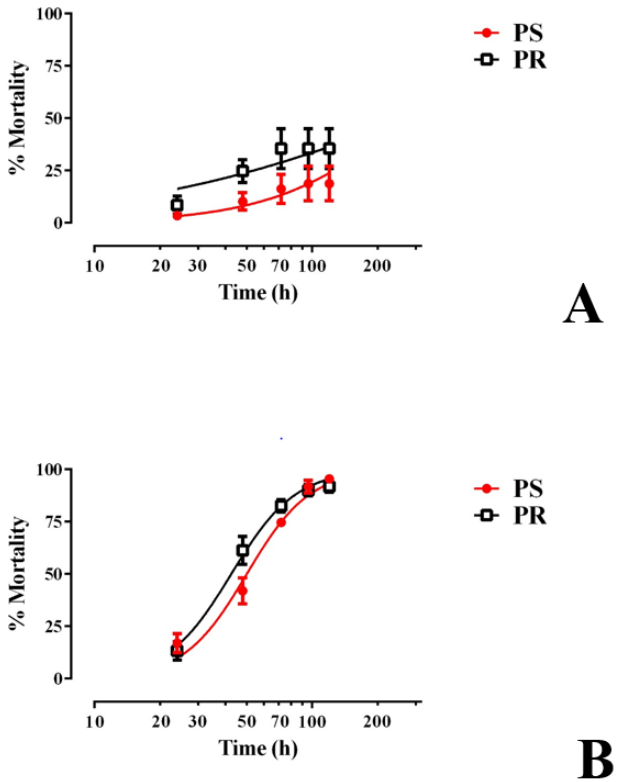
Figure 3. Chronic larval toxicity of E1800 against representative pyrethroid-susceptible (PS, red) and pyrethroid-resistant (PR, black) strains of Ae. aegypti . E1800 was tested at concentrations of ( A ) 0.1 mg/mL or ( B ) 0.25 mg/mL. The ‘x axis’ in both panels is log transformed and represents the time in which larvae were exposed to E1800 up to 120 h; points after this time remained consistent until the experiment was finalized (14 days = 264 h). Values plotted are means ± standards errors of the mean based on four replicates of 30 larvae for PS or six replicates of 30 larvae for PR. At 0.25 mg/mL E1800, the median lethal time (LT 50 ) of the PR strain (42.5 h, 38.7–46.6 h 95% CI) was significantly lower (F test, p < 0.05) than that of the PS strain (50.1 h, 45.9–54.6 h 95% CI).